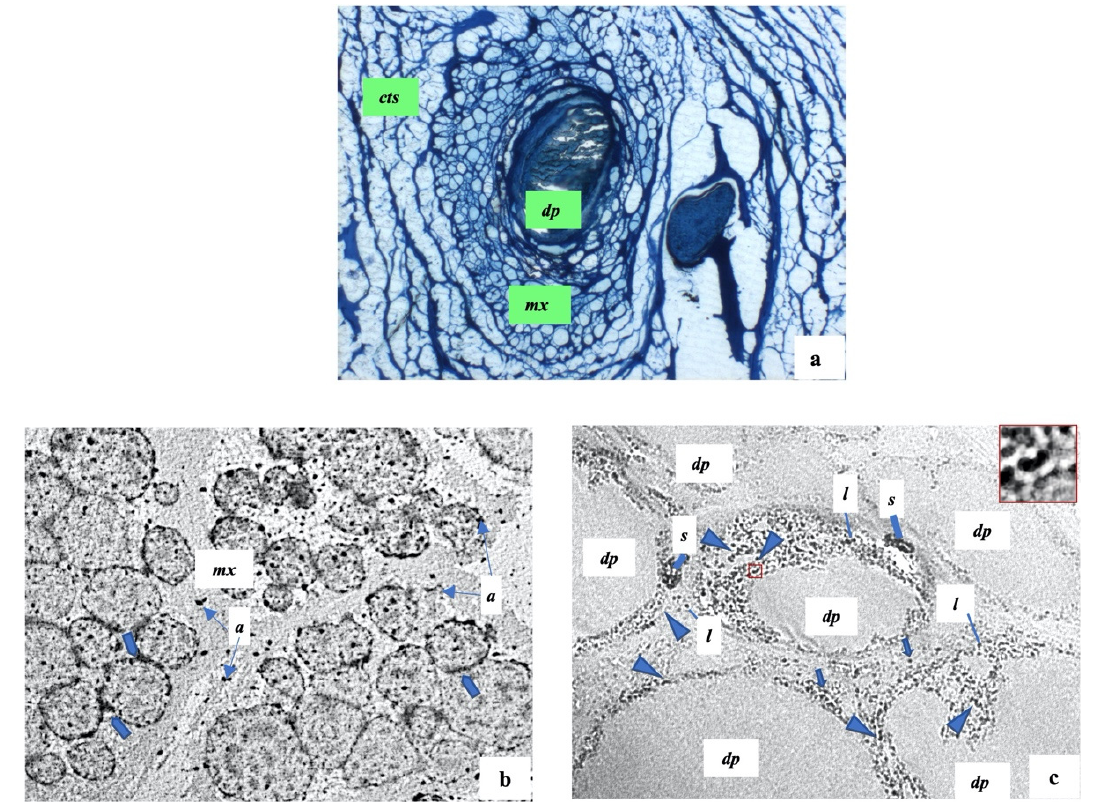
Figure 5. Scalp hair follicles in alopecia areata. ( a ) A representative semithin section shows: a follicular papilla ( dp ) with abundant flocculent substance; a hair matrix ( mx ) with many cells not well organized; cts : connective tissue sheath. ( b , c ) The representative ultrastructural sections of hair matrix and follicular papilla respectively show: mx : hair matrix; a : apoptotic debris; thick arrows: beaded membrane of keratinocytes; dp : follicular papilla; head arrows: bacteria infiltrations; s : melanosome structures; l : lymphocytes; red square: area of inset magnification. ( a ) 200 × ; ( b ) 1750 × ; ( c ) 12,500 × .